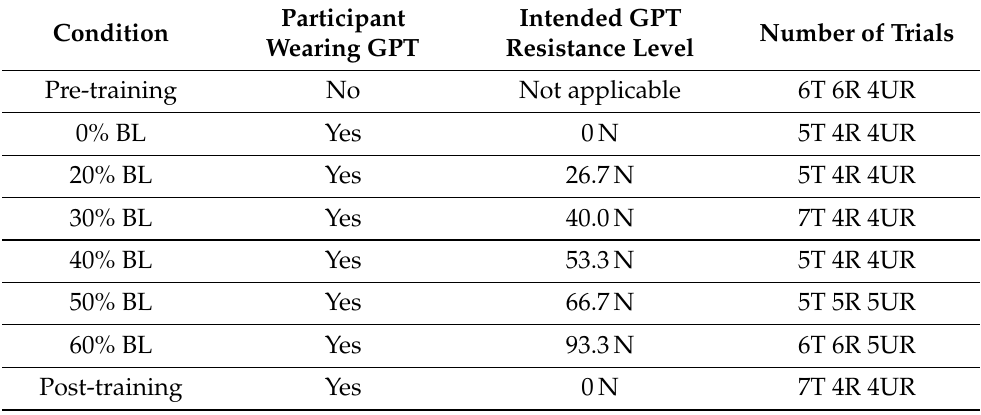
Table 1. Tested conditions with the healthy participant in the pilot study, BL = 133.3N. For number of trials, the letter designations T, R, and UR represent the numbers of total, good for resisted leg, and good for unresisted leg trials.